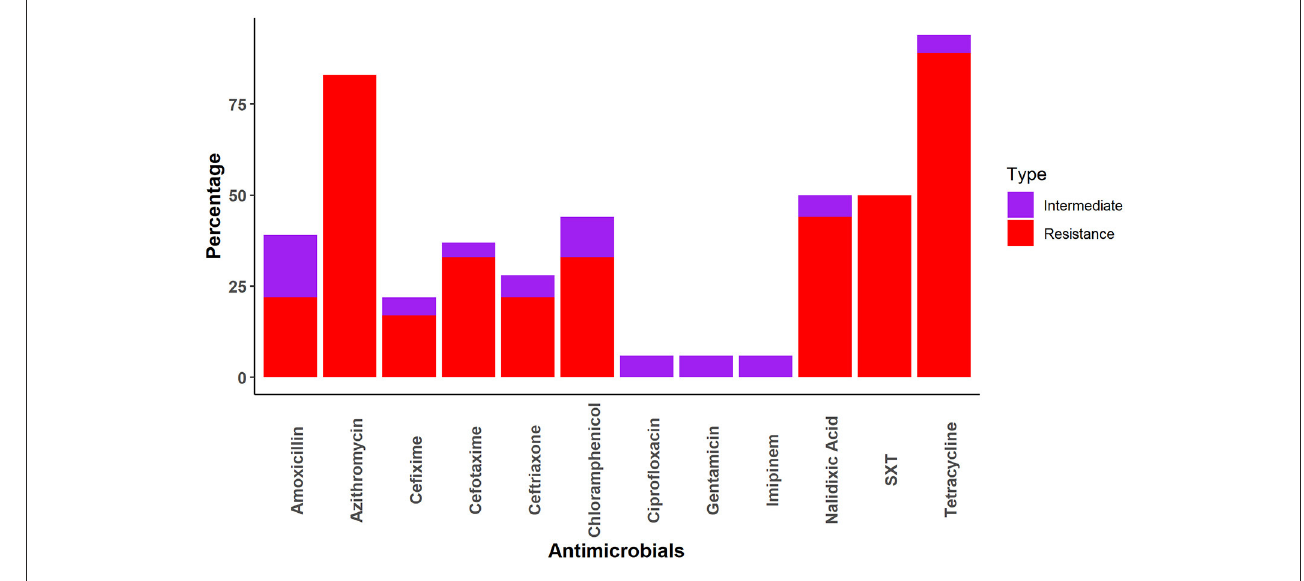
FIGURE2 AMR pattern of Salmonella spp.